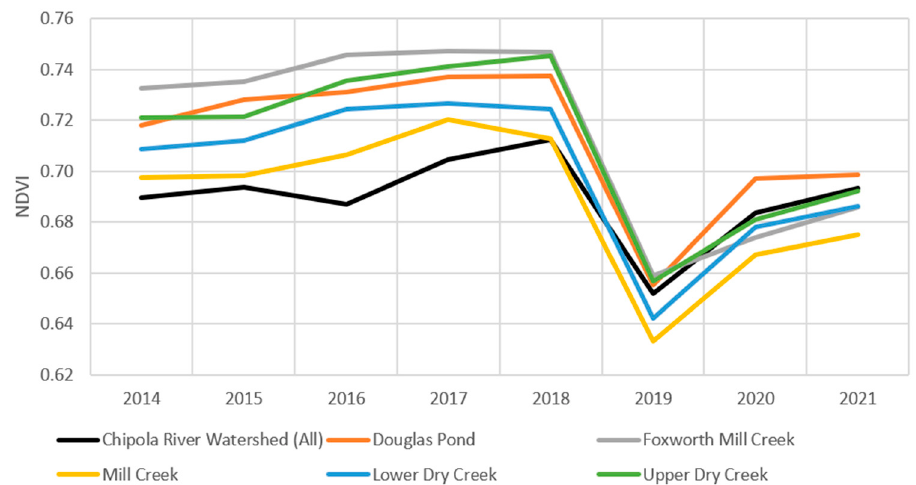
Figure 5. Changes in average growing season MODIS NDVI of severely impacted HUC12 subwatersheds by Hurricane Michael located in the southern portion of the Chipola River Watershed. Growing season for this analysis was defined as May through October.